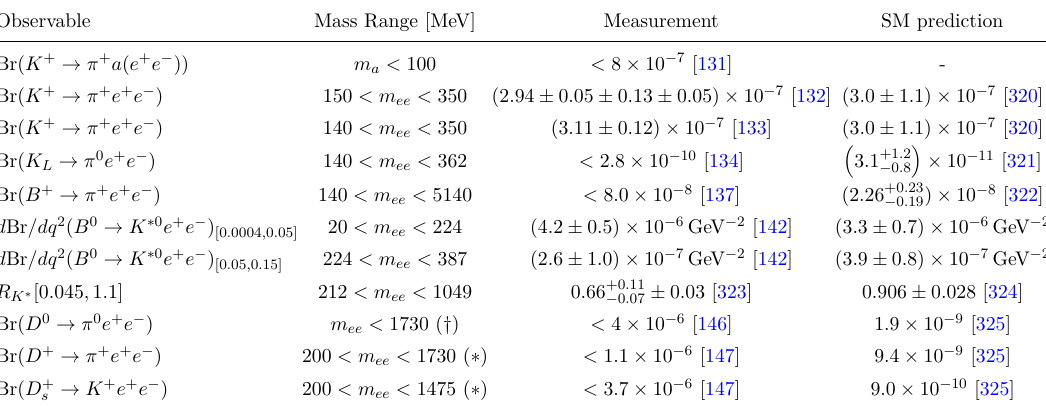
Table 5 . Observables with an electron pair in the final state. Bounds are at 90% CL. Here we only include observables for which the electron invariant mass can be below or near the dimuon threshold, on the grounds that above it muonic observables will generically provide stronger bounds. Predictions without accompanying citations have been calculated using flavio [326]. In the measurements of the D branching ratios, cuts are applied to exclude the region around the φ resonance. For ( s ) the Babar measurements with a ( ∗ ) , the excluded region is 950 < m 1050 MeV, while the ee < BESIII measurement with a ( † ) excludes the region 935 < m 1053 MeV. Since the long-distance ee < contributions to these decays peak around this excluded resonance, we take the SM prediction to be only due to the short-distance contributions, as calculated in ref.